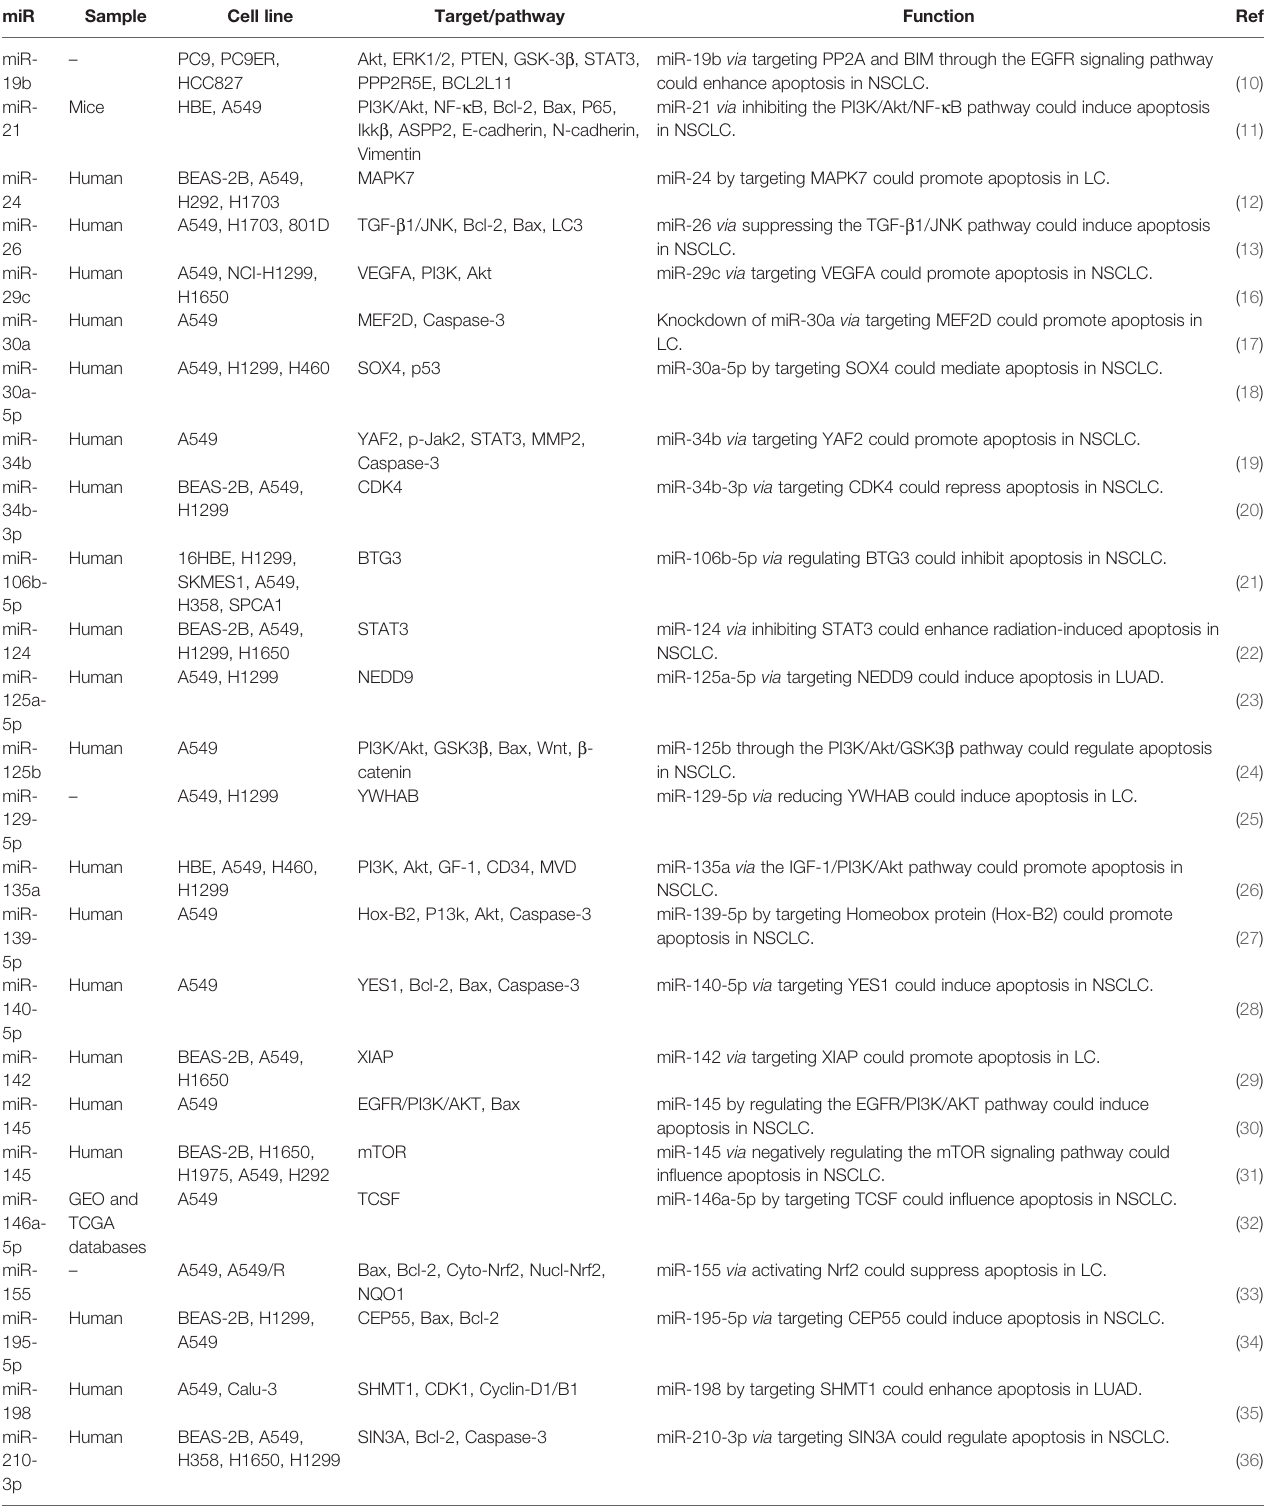
TABLE 1 | miRNAs regulating apoptosis in lung cancer.